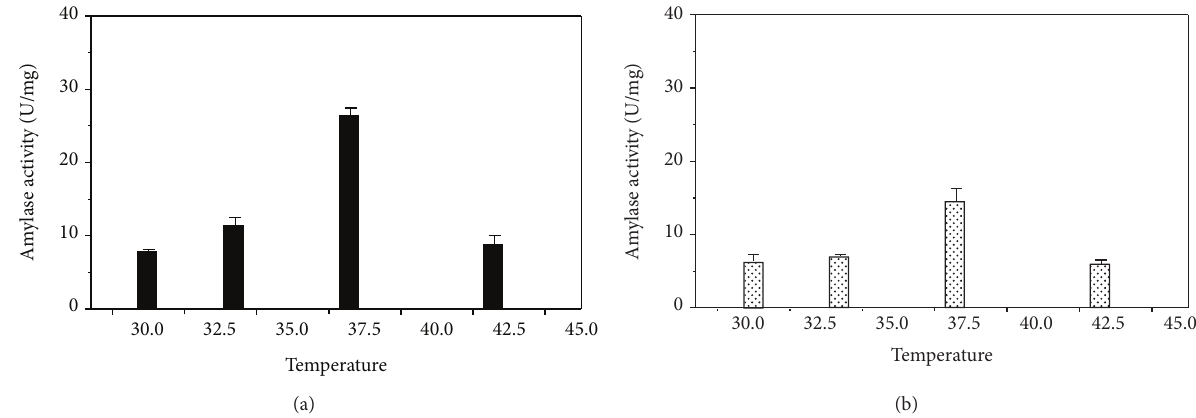
Figure 4: Effect of 0.1mM calcium (Ca +2 ) on amylase production after 48 hours of SSF at 37 ∘ C temperature; dotted column: specific activity of 𝛼 -amylase in absence of calcium ion from SSF extract; black column: specific activity of 𝛼 -amylase in presence of calcium ion from SSF